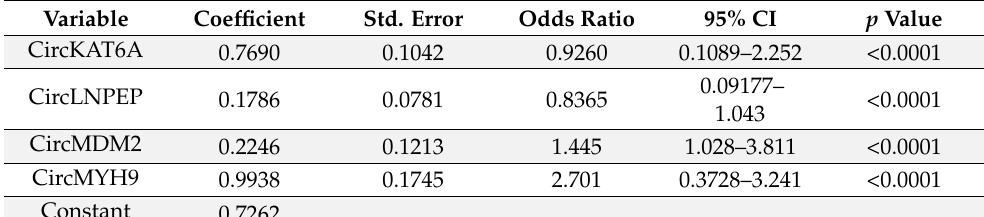
Table 3. Logistic regression of circRNAs in the training